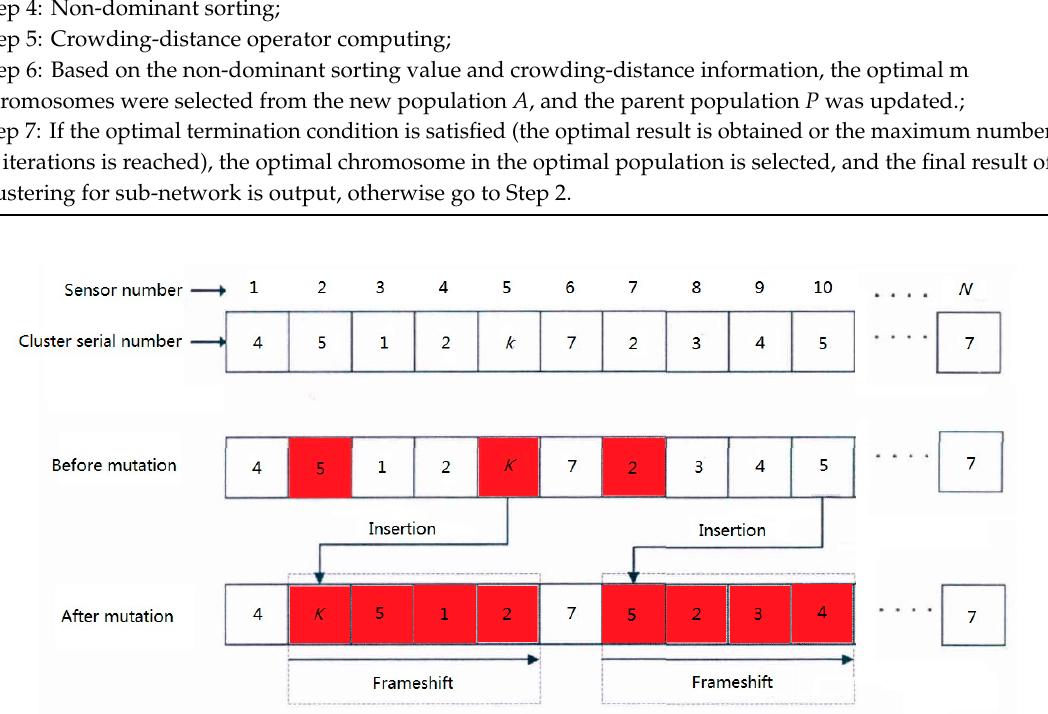
Algorithm 2 Multi-objective optimization of clustering by genetic algorithm